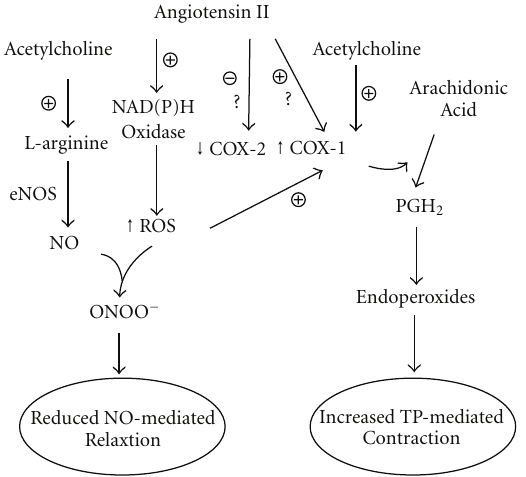
Figure 1: Hypothetic involvement of cyclooxygenase (COX) isoforms in angiotensin II- (AngII-) induced endothelial dysfunction. Ang II promotes reactive oxygen species (ROS) generation by vascular NAD(P)H oxidase activation. ROS rapidly react with nitric oxide (NO), leading to reduce its availability and to produce peroxynitrites (ONOO − ). Ang II might also directly downregulate COX-2 or upregulate COX-1. COX-1 is also activated by acetylcholine. Under such conditions, ROS stimulate COX-1 to transform arachidonic acid into endoperoxides, which in turn activate the contracting thromboxane-prostanoid (TP)